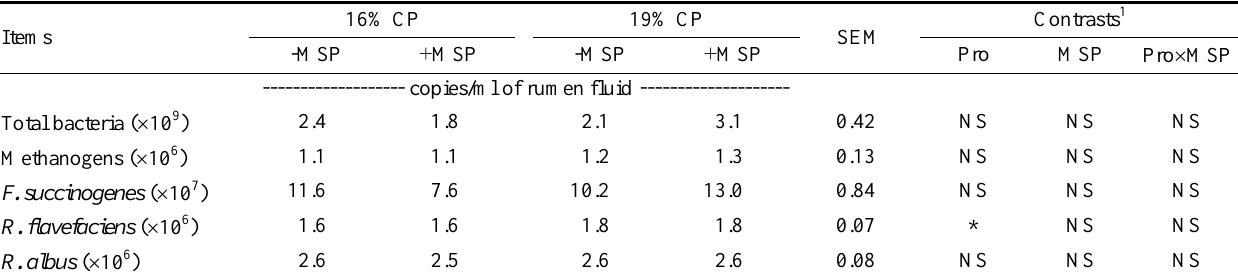
Table 5. Effect of protein level and mangosteen peel pellets (Mago-pel) in concentrate diet on rumen total bacterial methanogen and predominant cellulolytic bacteria using real-time PCR technique Items